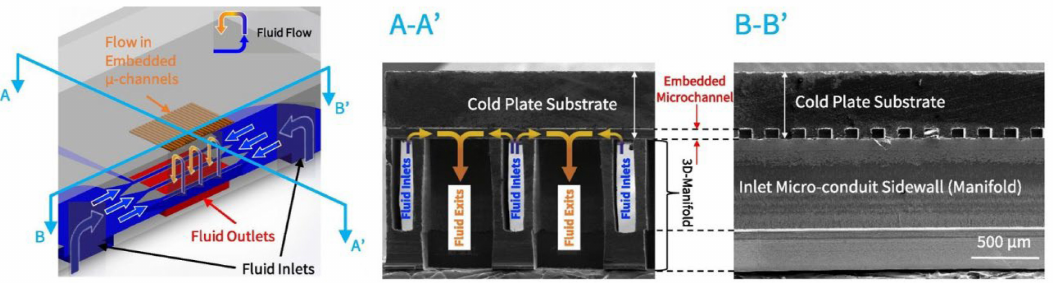
Figure 8. Schematic of ( a ) the conventional baseplate cooling with a pin fin structure and ( b ) the novel directly cooled HybridPACK TM power modules with ribbon bonded cooling structures [81,83].